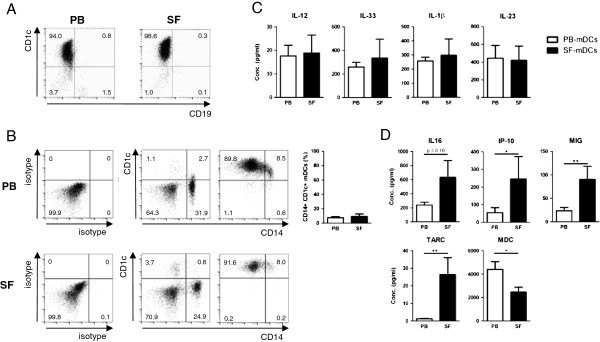
CD1c+ myeloid dendritic cells from synovial fluid of rheumatoid arthritis patients produce increased chemokine levels but equal amounts of T cell-differentiating cytokines compared with those from peripheral blood. (A) Representative dot plot of isolated CD1c-expressing myeloid dendritic cells (mDCs) from peripheral blood (PB) and synovial fluid (SF) of a rheumatoid arthritis (RA) patient. (B) Representative dot plots of isotype (left), CD1c and CD14 expression on CD19– mononuclear cells (middle) and on isolated mDCs (right plot) from PB and SF. A small percentage of mDCs from PB and SF (n = 6, paired samples) expresses CD14 (bar graph). (C) PB mDCs and SF mDCs (n = 6) produced comparable levels of T-helper type (Th)-1, Th17 and Th2-differentiating cytokines interleukin (IL)-12, IL-23, IL-33. (D) Production of several chemokines by SF mDCs was significantly upregulated and macrophage-derived chemokine (MDC) significantly downregulated as compared with PB mDCs. Apart from the T cell-differentiating cytokines, only inflammatory mediators that showed P ≤0.10 are shown. Statistically significant differences of *P <0.05 and **P <0.01. IP-10, interferon-gamma inducible protein-10; MIG, monokine induced by interferon-gamma; TARC, thymus and activation-regulated chemokine.